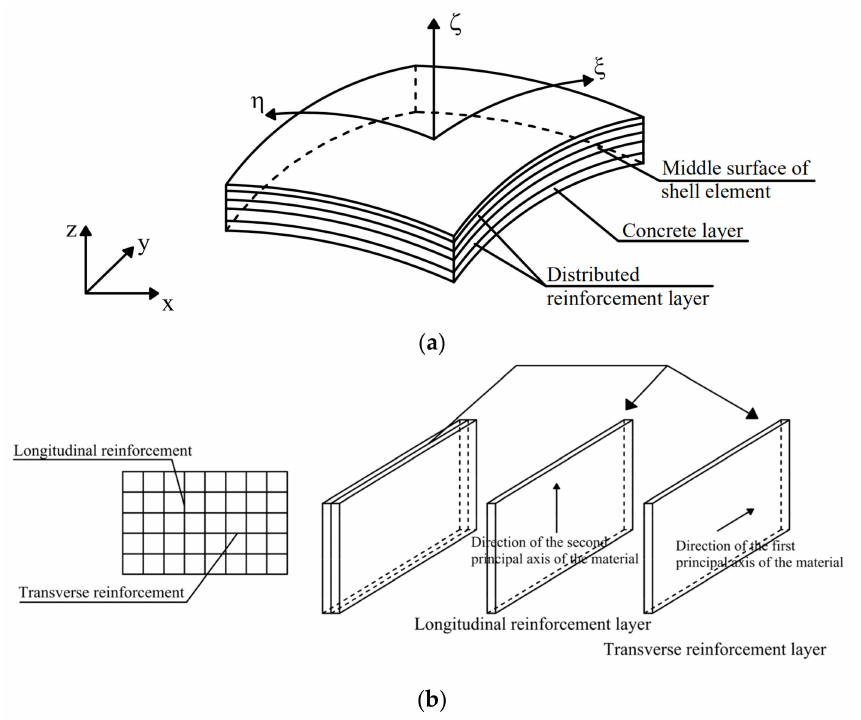
Figure 3. Schematic representation of the layered shell element developed by Lu’s team: ( a ) Layered shell element; ( b ) Reinforcement layer